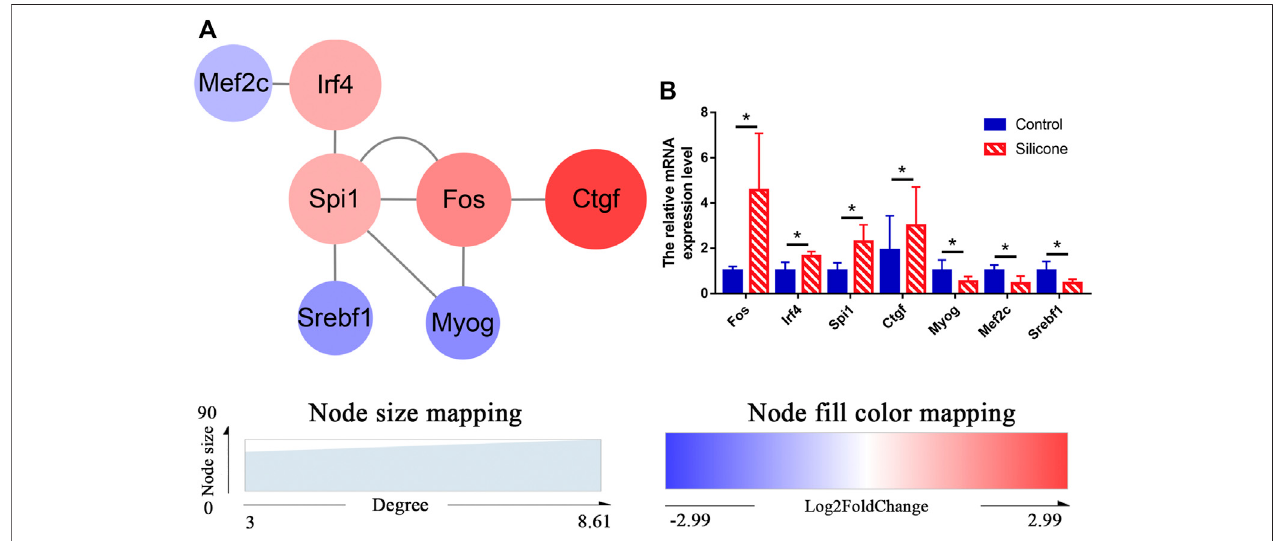
FIGURE7| RegulationofTFs-DEmRNAsinteractionsusingtranscriptionfactordatabases. (A) RegulatorynetworksofTFs-DEmRNAsinteractionsactivatedbythe FBR to silicone implants. (B) Relative levels of mRNA for Fos, Spi1, Irf4, Ctgf, Myog, Mef2c, and Srebf1 using qPCR. * p < 0.05.